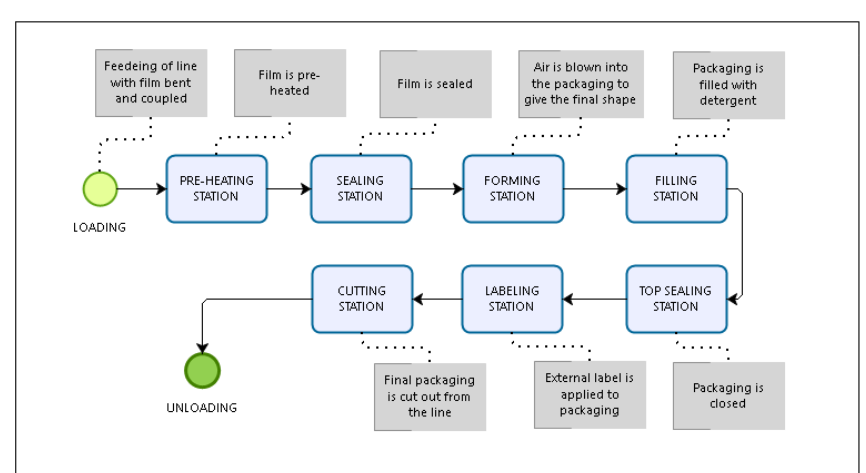
Figure 1 – Scheme of production